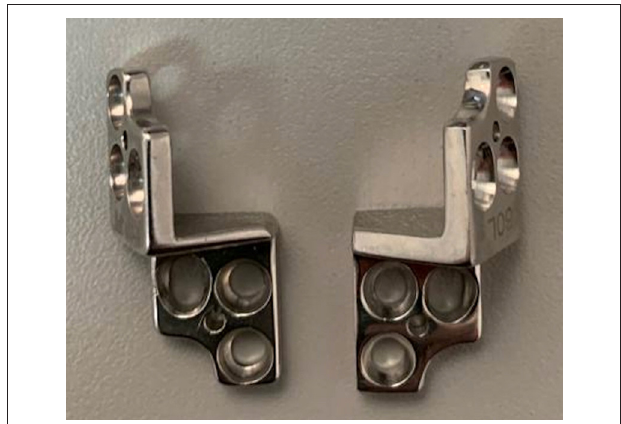
FIGURE 1 | Plate used for pelvic osteotomies (Courtesy M/S Pakrom International, Sialkot, Pakistan).